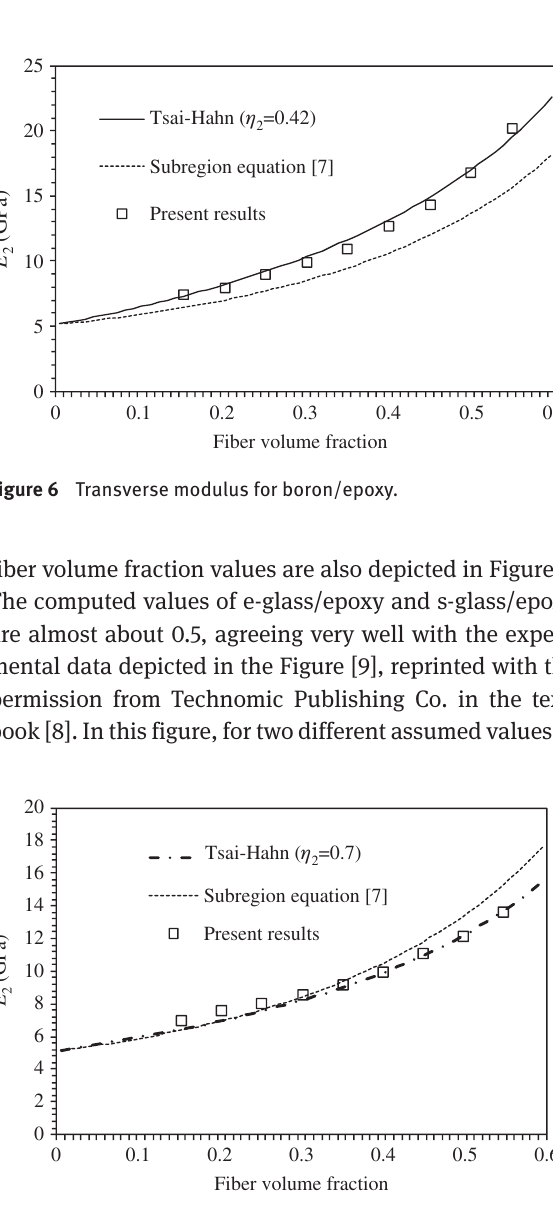
Figure 7 Transverse modulus for T300/epoxy.